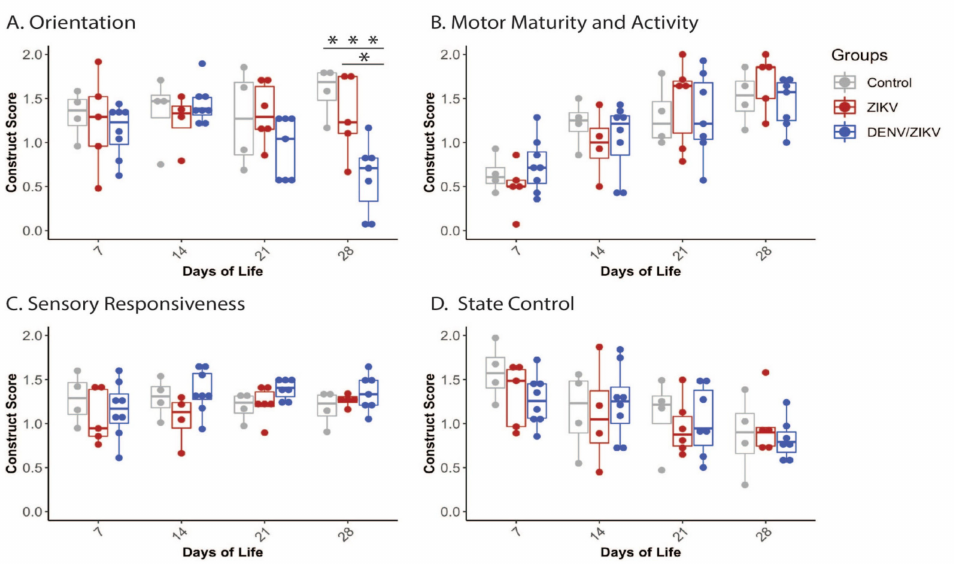
Figure 2. Neonatal neurodevelopment in the first month of life. Neurodevelopment was measured by the SNAP at 7, 14, 21, and 28 days of life. Scores in the ( A ) Orientation, ( B ) Motor Maturity and Activity, ( C ) Sensory Responsiveness, and ( D ) State control constructs are illustrated. * = p < 0.05, *** = p <